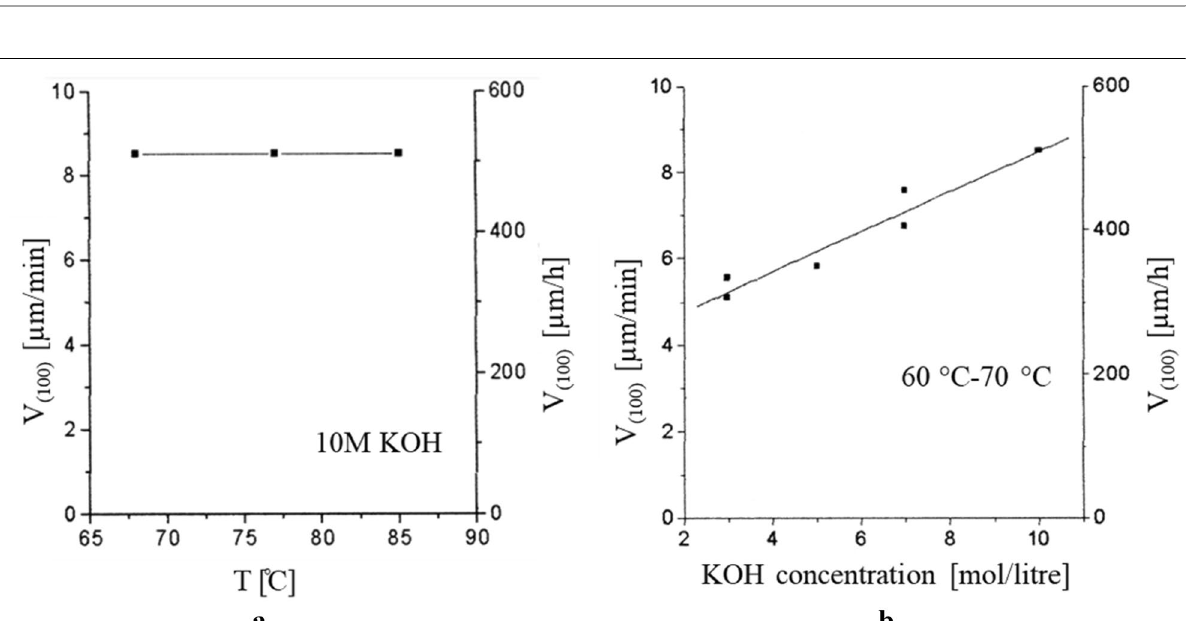
Fig. 11 SEM images of 1 μm wide deep grooves showing the comparison of etch uniformity under three etching conditions in 41 wt% KOH at 60 ℃ for 6 h: a no agitation, b ultrasonic agitation with a single frequency of 28 kHz, and c ultrasonic agitation with 28, 45, 100 kHz frequencies applied sequentially for 1 ms duration [83], © 1995, IEEE